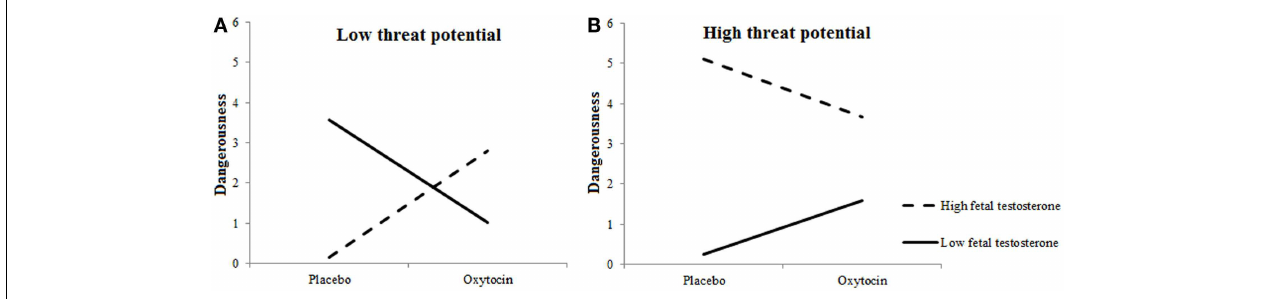
FIGURE 5 | Fetal testosterone exposure moderates effects of oxytocin on perceived dangerousness of included targets. Low-threat targets (A) are seen as more dangerous and high-threat targets (B) as less dangerous by individuals with high fetal testosterone exposure when given oxytocin rather than